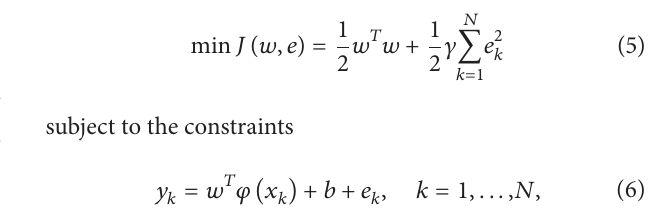
model. The important feature of PLSR is based on latent variables (LVs)